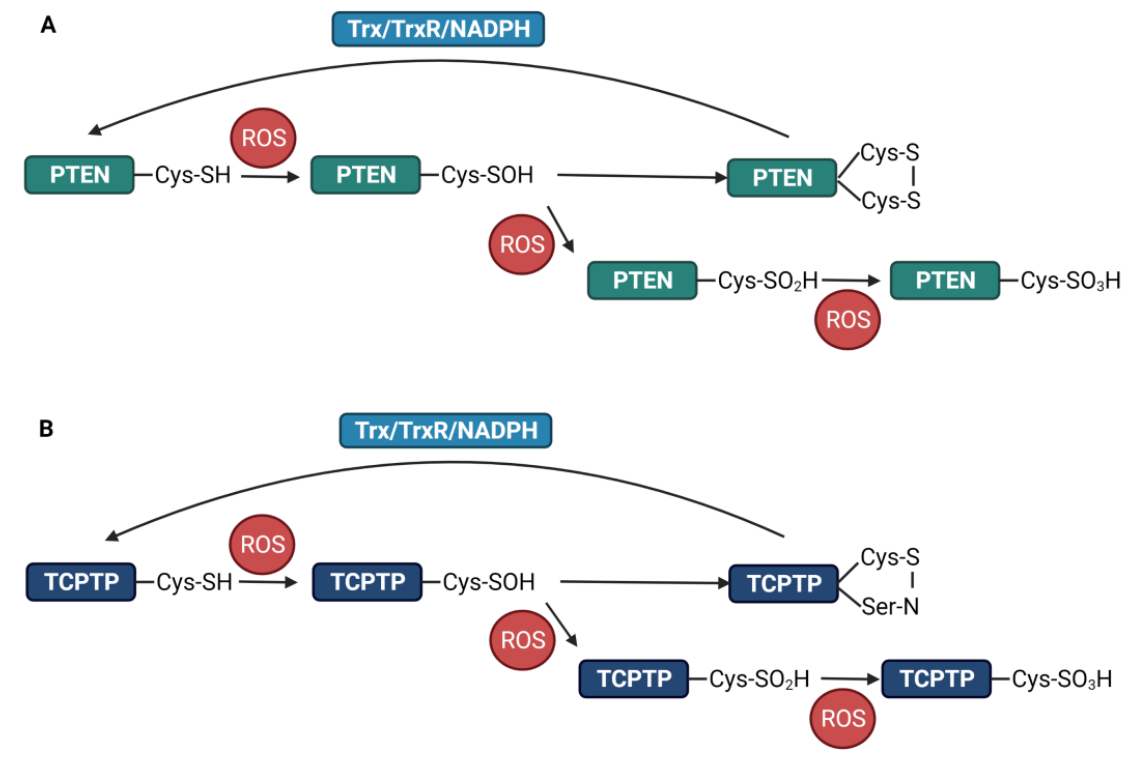
Figure 1. Redox regulation of PTEN and TCPTP by ROS. ( A ). PTEN is reversibly oxidized by ROS and forms a disulfide bond between two cysteine residues. The Trx/TrxR/NADPH system is responsible for the reduction of oxidized PTEN. PTEN may undergo hyperoxidation upon exposure to high levels of ROS. ( B ). TCPTP oxidation into a reversible -SOH is thought to produce a sulfenamide with an adjacent nitrogen atom. The Trx system also plays a key role in reducing oxidized TCPTP. An amount of TCPTP undergoes hyperoxidation into irreversible -SO 2 H and -SO 3 H.